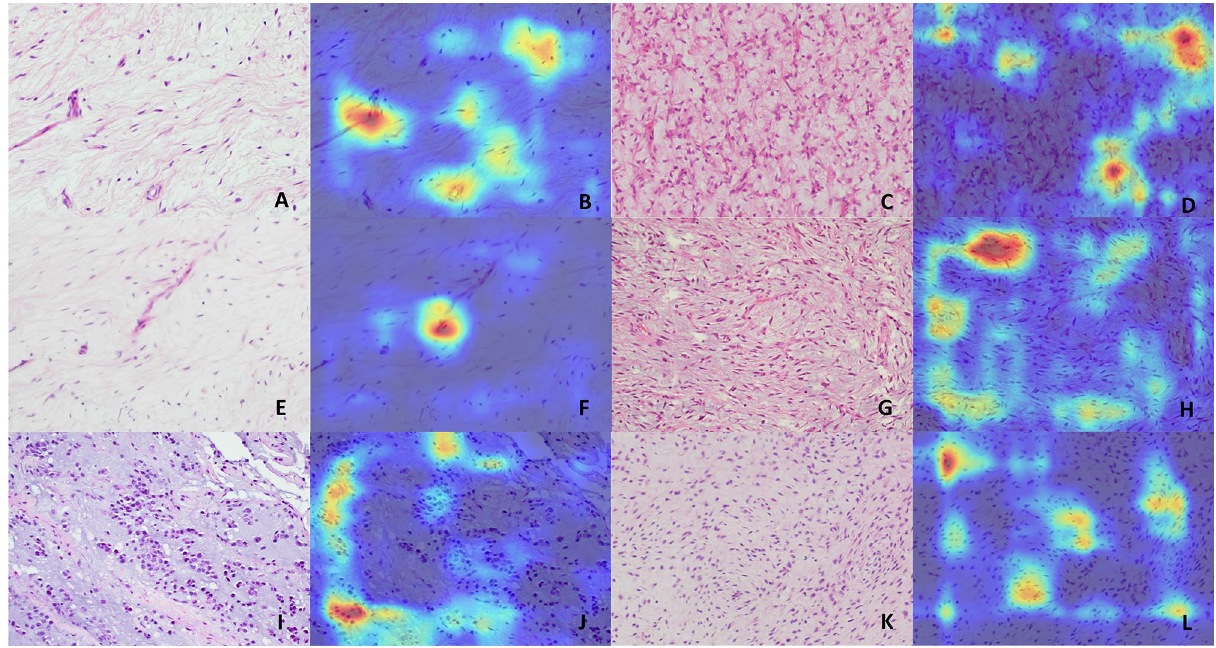
Figure 5. Example images and heatmaps generated by the deep learning model of ( A , B ) Intramuscular myxoma, ( C , D ) Myxoid liposarcoma, ( E – H ) Myxofibrosarcoma, ( I , J ) Extraskeletal myxoid chondrosarcoma, and ( K , L ) Low-grade fibromyxoid sarcoma. The images are mainly activated over tumour nuclei and the vessels. There are subtle sub-visual differences of tumour nuclei and vessels, especially between intramuscular myxoma and myxofibrosarcoma, that are not noticeable by human